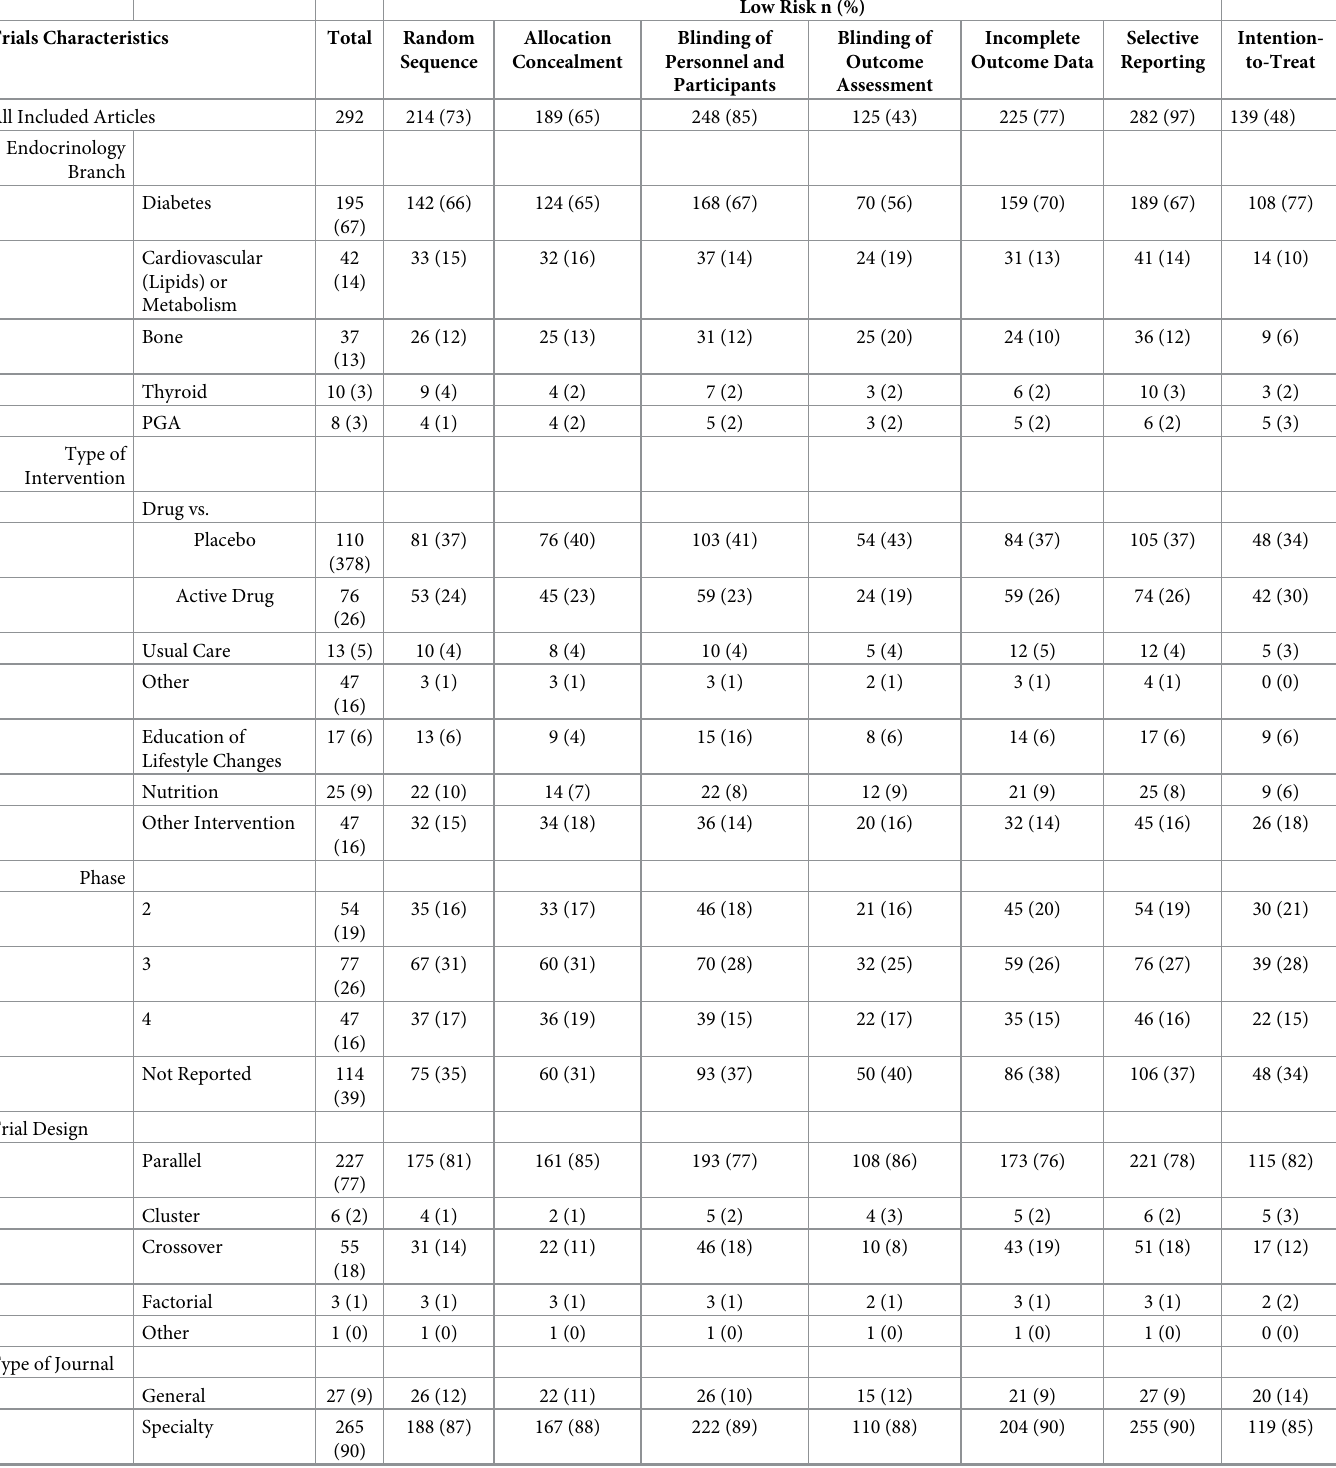
Table 2. Low risk assessment of the seven domains from the Cochrane Risk of Bias